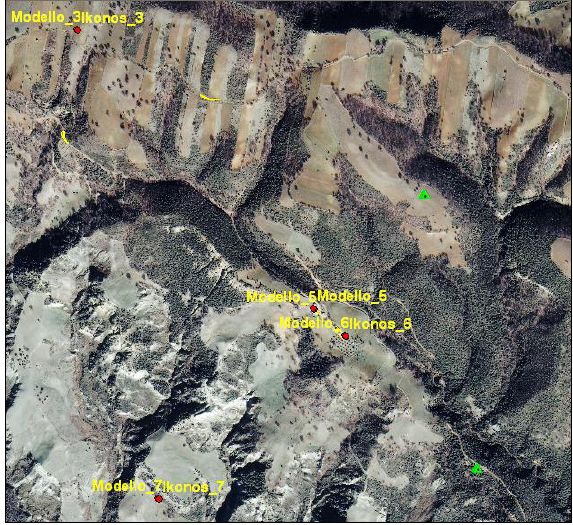
Figure 3. Some Ground Control Point (test 1)